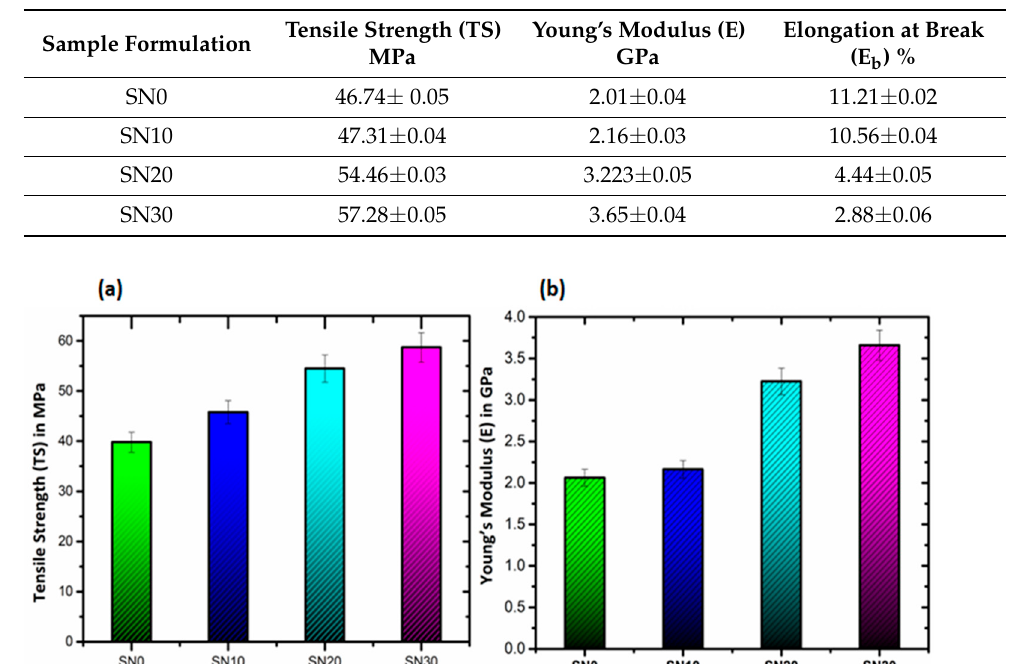
Table 3. Data of tensile strength, Young’s modulus and elongation at break for pristine PS and PS/m-BN composites.